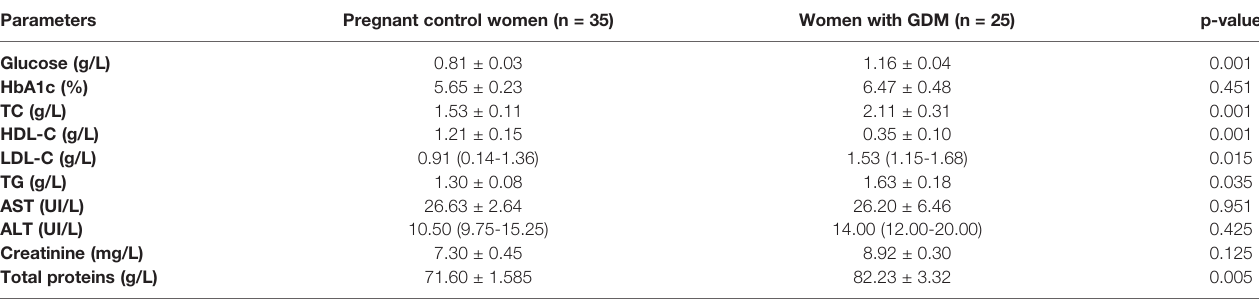
TABLE 2 | Biochemical parameters in women with GDM and pregnant